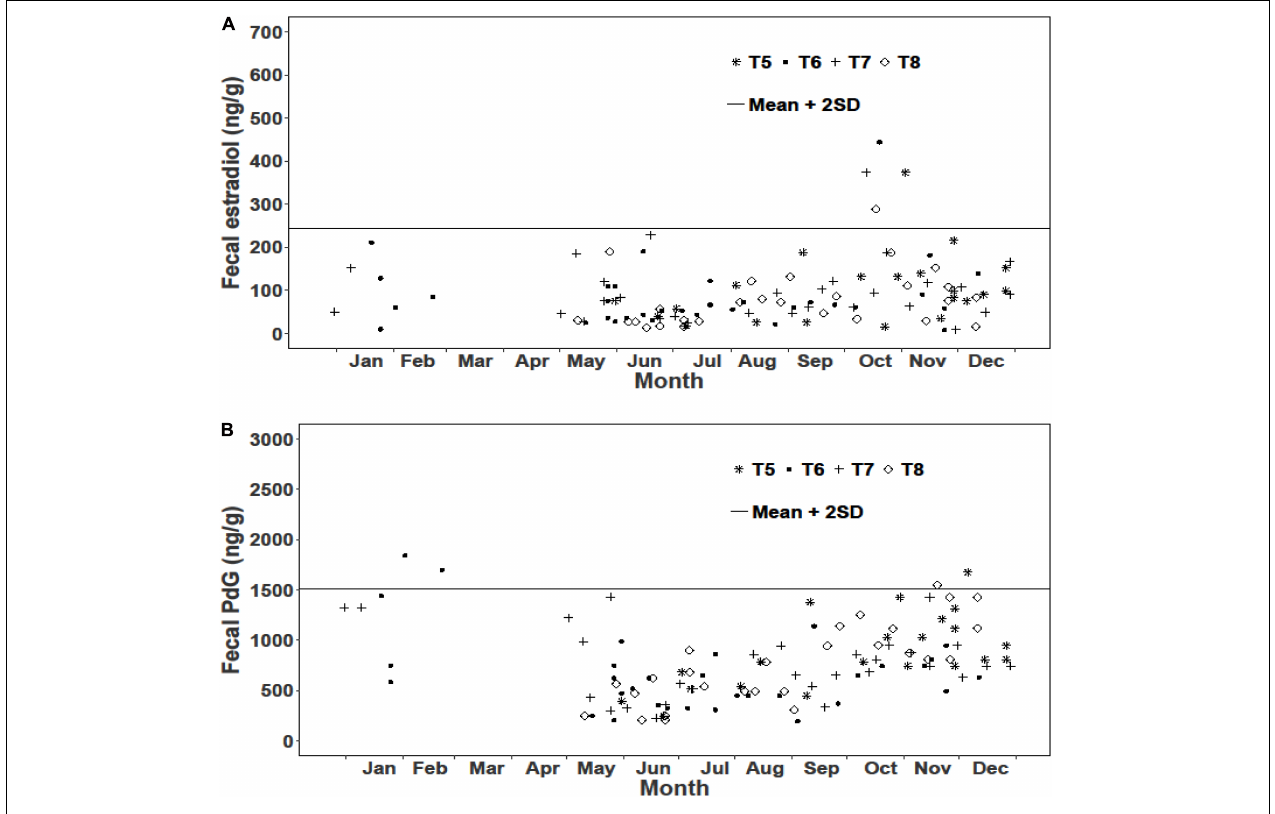
FIGURE 4 | Fecal hormone metabolite concentrations in goral in different sampling trails (T5, T6, T7, and T8) (A) Estradiol; (B)